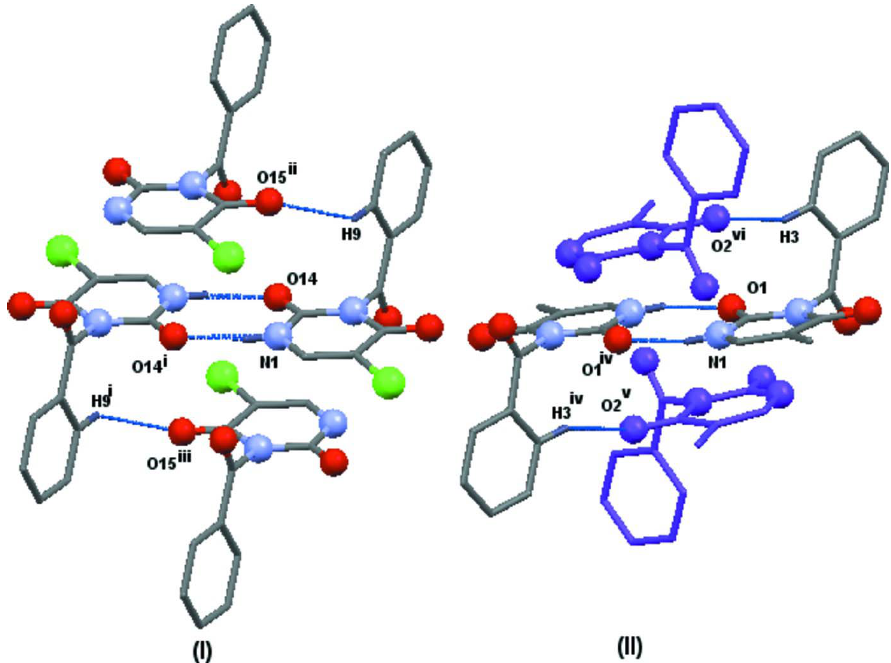
Figure 2 Comparison of similar hydrogen bond interactions (dotted lines) in (I) & (II) (MERCURY; Bruno et al. , 2002). Only the hydrogen atoms involved are included. Nitrogen and Oxygen atoms are shown as balls. Colours: Nitrogen, blue (light gray); Oxygen, red (black); Carbon, (gray); Hydrogen, dark blue. Coordinates of (II) are labelled as in deposited data (SEVQUG) and additional molecules shown in purple for clarity. Symmetry Codes: (i) 3/2 - x , 5/2 - y , 1 - z (ii) x , y + 1, z (iii) 3/2 - x , 3/2 - y , 1 - z (iv) 2 - x , 1 - y , - z (v) 1/2 + x , 1/2 - y , - z (vi) 3/2 - x , 1/2 + y ,